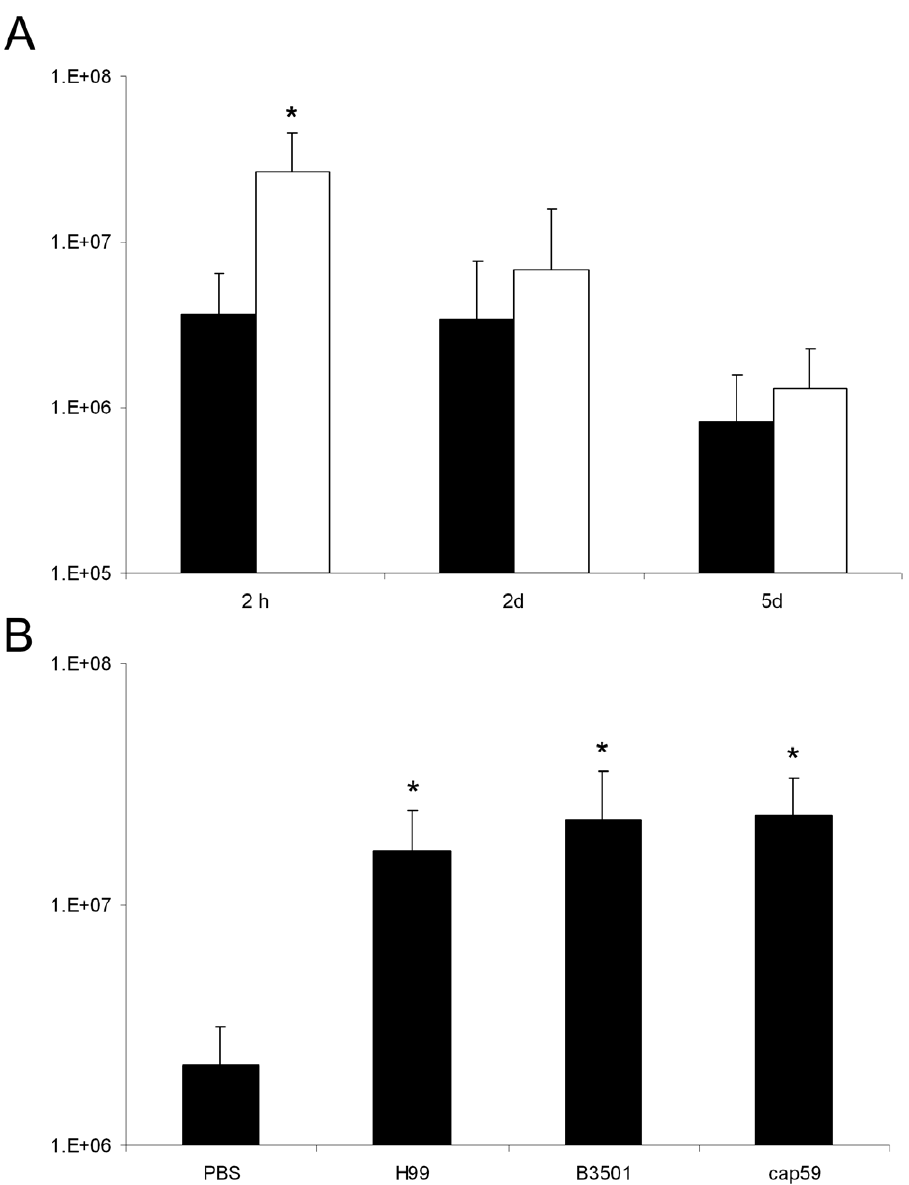
Figure 1. Haemocyte density in larvae after C.neoformans injection. A ) Ten larvae were inoculated with 10 4 cells from H99 strain and haemocyte densities were assessed at different times (2 h, 2 d and 5 d). Black bars show haemocyte density of larvae injected with PBS and white bars of larvae injected with C. neoformans . B ) Ten larvae per group were inoculated with 10 4 cells from H99, B3501 and the cap59 mutant (C536) and haemocyte densities were assessed after 2 h after inoculation as described in Material and Methods. In both A and B, significant differences ( p , 0.05) in haemocyte density relative to that in the PBS treated larvae are indicated with an asterisk. Experiments were repeated 3 times.